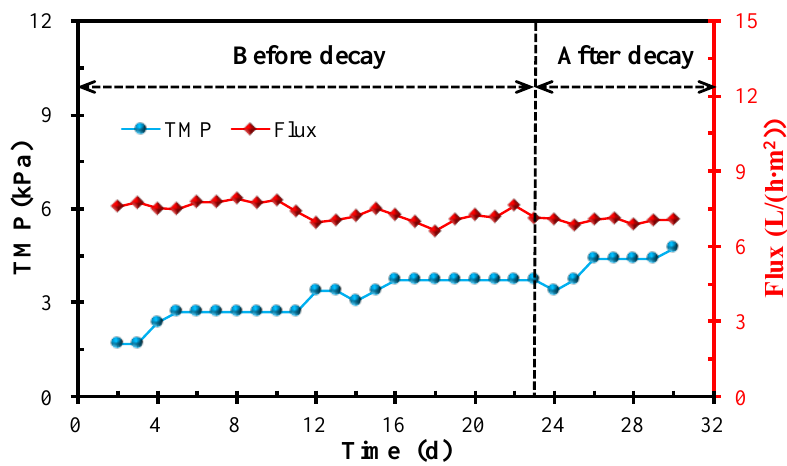
Figure 7. Variations in TMP and flux for the MPBR system.